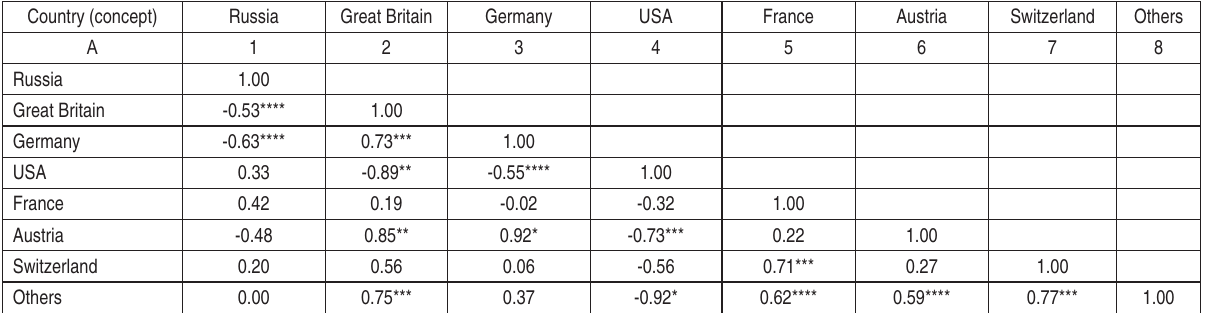
Table 1. Coefficients of pair correlation between reinsurance flows of